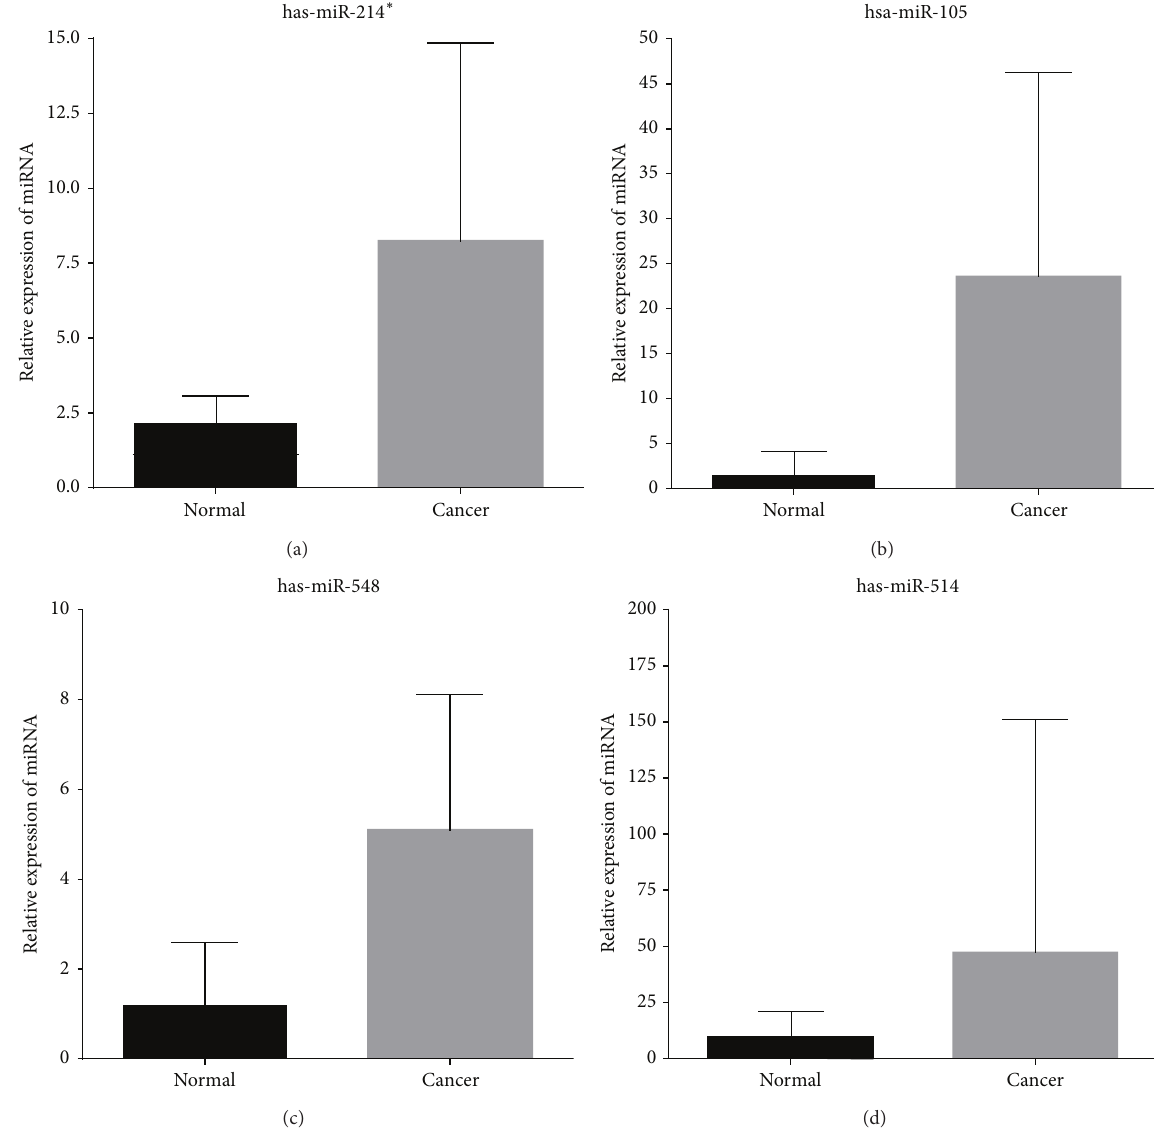
Figure 4: The miRNA expression level of has-miR-214 ∗ (a), has-miR-105 (b), has-miR-548n (c), and has-miR-514b (d) detected by qRT-PCR in cancerous and normal tissues. Relative gene expression was calculated as 2 −ΔΔ CT